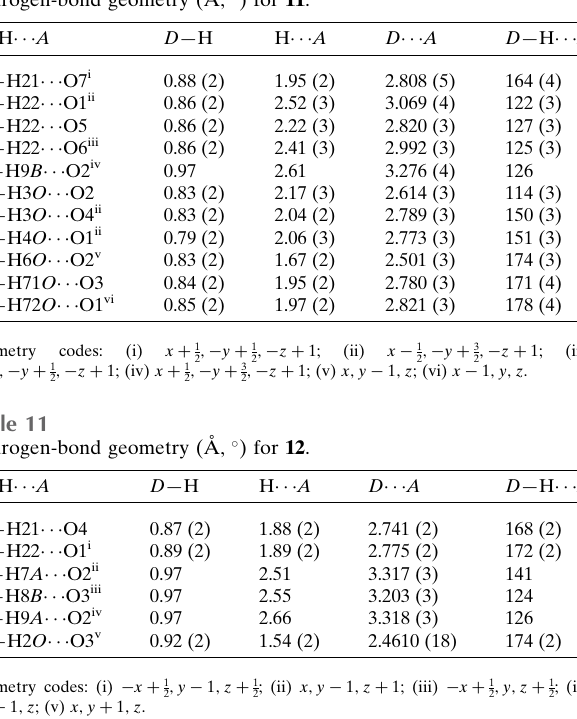
(24) ring with a topology 8